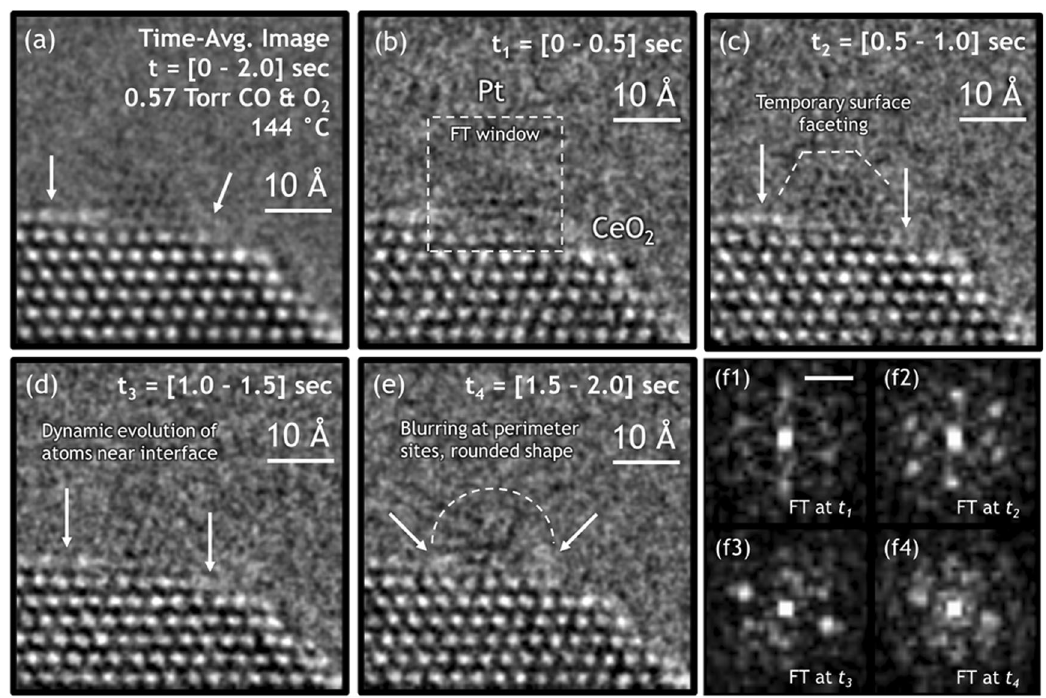
Fig. 2 Fluxional behavior observed under CO oxidation reaction conditions. In situ ETEM image time-series of CeO 2 -supported Pt NP at 144 °C in 0.57 Torr of CO and O 2 . a Time-averaged image of the catalyst, obtained by summing together the individual 0.5 s exposure frames over the entire [0 – 2.0] s acquisition period. b – e Atomic-scale structural dynamics that evolve over 0.5 second intervals from t = 0 s to t = 2.0 s. f1 – f4 FT taken at each time interval from the windowed region around the Pt NP, as denoted in ( b ). The scale bar in ( f1 ) is 5.0 nm-1. Images have been processed with a bandpass fi lter for clarity. FTs were produced from un fi ltered, windowed images that were processed with a Hanning function to remove edge artifacts caused by windowing; the modulus of the FT is